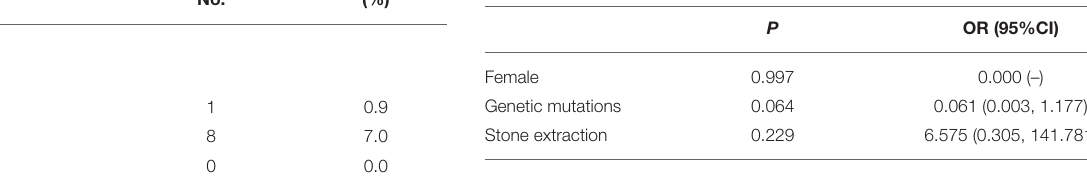
TABLE 6 | PEP impact of female, genetic mutations, and stone extraction on the risk of